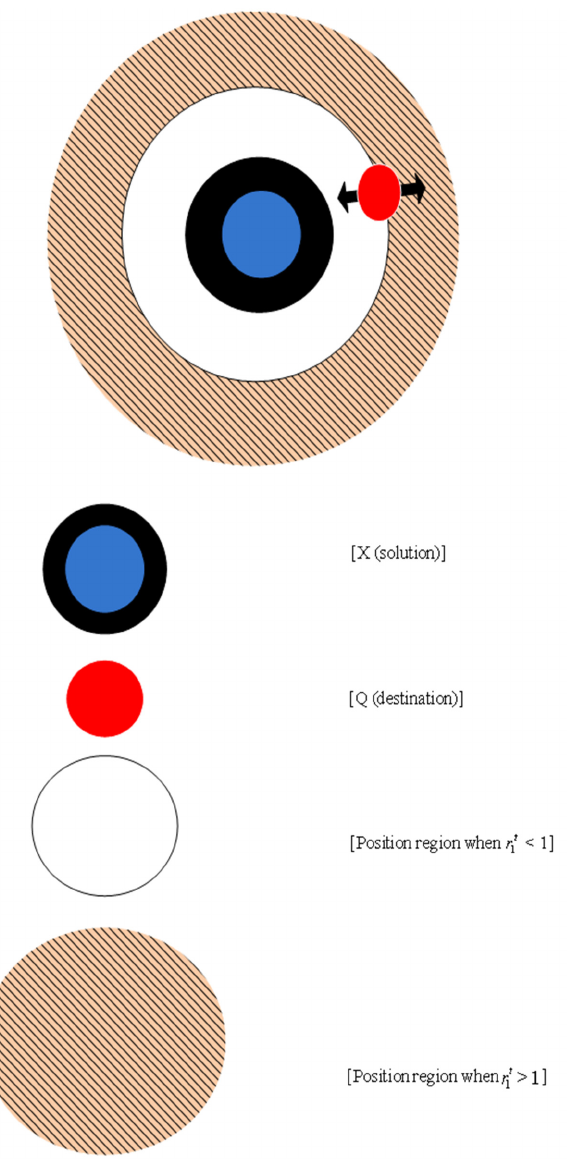
Figure 7. Sine and cosine effects on the forthcoming locality in Equations (57) and (58).